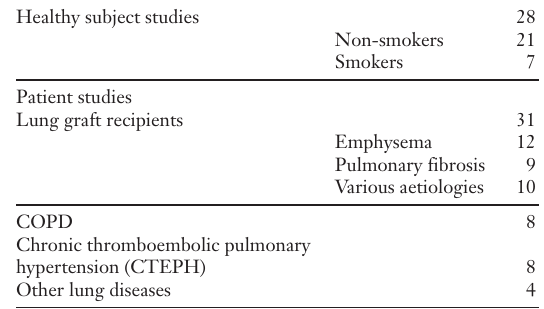
Experience of the Mainz 3 He Group